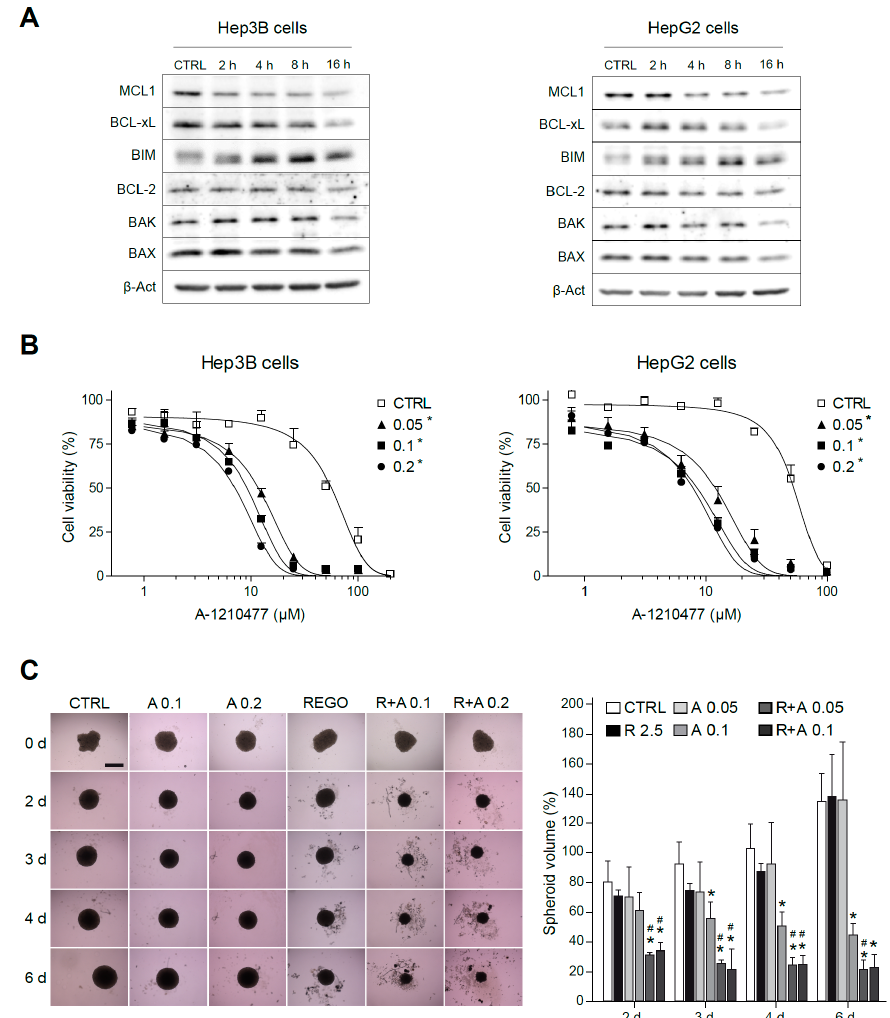
Figure 5. MCL-1 inhibition sensitizes hepatoma cells to the BCL-xL inhibitor A-1331852. ( A ) Representative Western blot images of MCL-1, BCL-xL, BIM, BCL-2, BAX, BAK, and β -Actin exhibited by Hep3B and HepG2 cells at different times (0–16 h) after regorafenib treatment (5 µM). ( B ) Effect of the MCL-1 inhibitor A-1210477 on Hep3B cells and HepG2 cells treated with A-1331852 ( A , 0.05, 0.1, or 0.2 µM) for 24 h. * p < 0.05 vs. control cells. ( C ) Hep3B spheroids were seeded and after 24 h of aggregation treated with vehicle, regorafenib (R, 2.5 µM), and/or A-1331852 (A, 0.1 or 0.2 µM) for seven days. Spheroid growth was monitored daily (scale bar, 500 µm). (n = 3) * p < 0.05 vs. control cells, # p < 0.05 vs. regorafenib-treated cells.